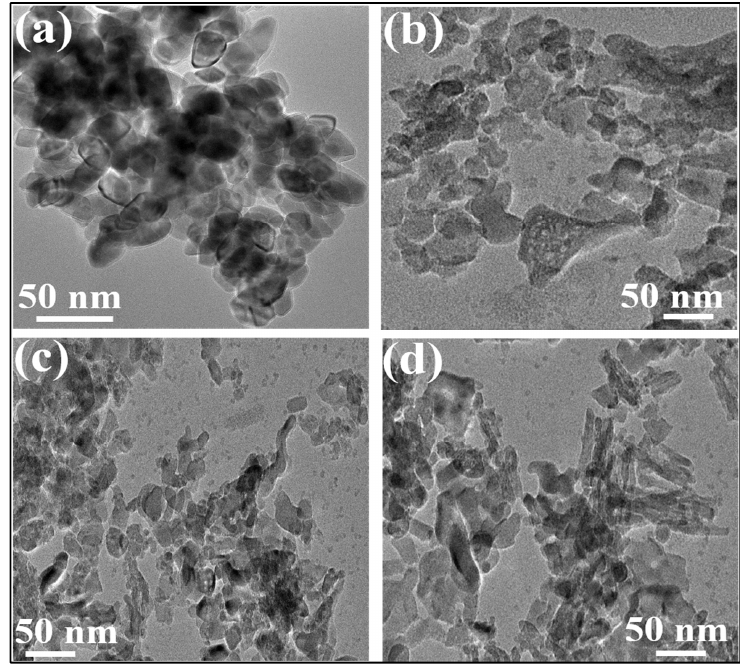
Figure 3. TEM images of ( a ) pure Fe 2 O 3 , ( b ) Zn 2%, ( c ) Zn 4% and ( d ) Zn 6%